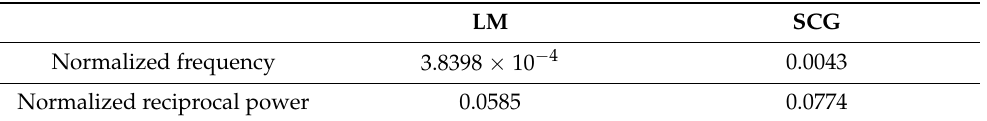
Figure 14. Regression diagrams for the ANN trained by applying scaled conjugate gradient algorithm calculated for ( a ) training dataset ( b ) validation dataset ( c ) dataset used for testing and ( d ) dataset with all three aforementioned groups of data. Table 3. Mean squared error calculated for the target data and the data generated by the ANN fitting functions obtained by applying the LM and SCG training